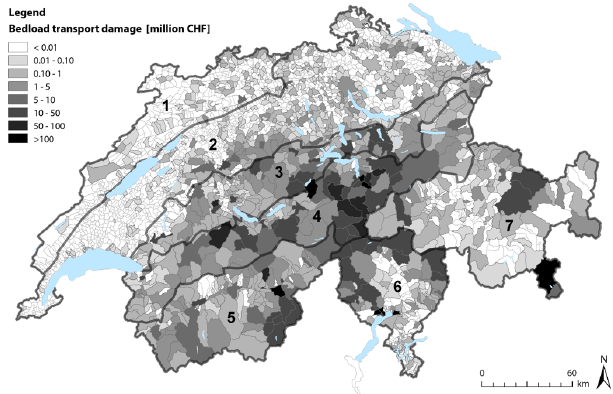
Fig. 3. Spatial distribution of damage costs caused by bedload pro- cesses over the entire 40yr study period at the municipal level (mean of the lower and upper estimates were applied). The bold black lines indicate the borders of the subareas (Fig. 1; Table 1). Note that CHF460–535million of losses could not distinctively be assigned to a single